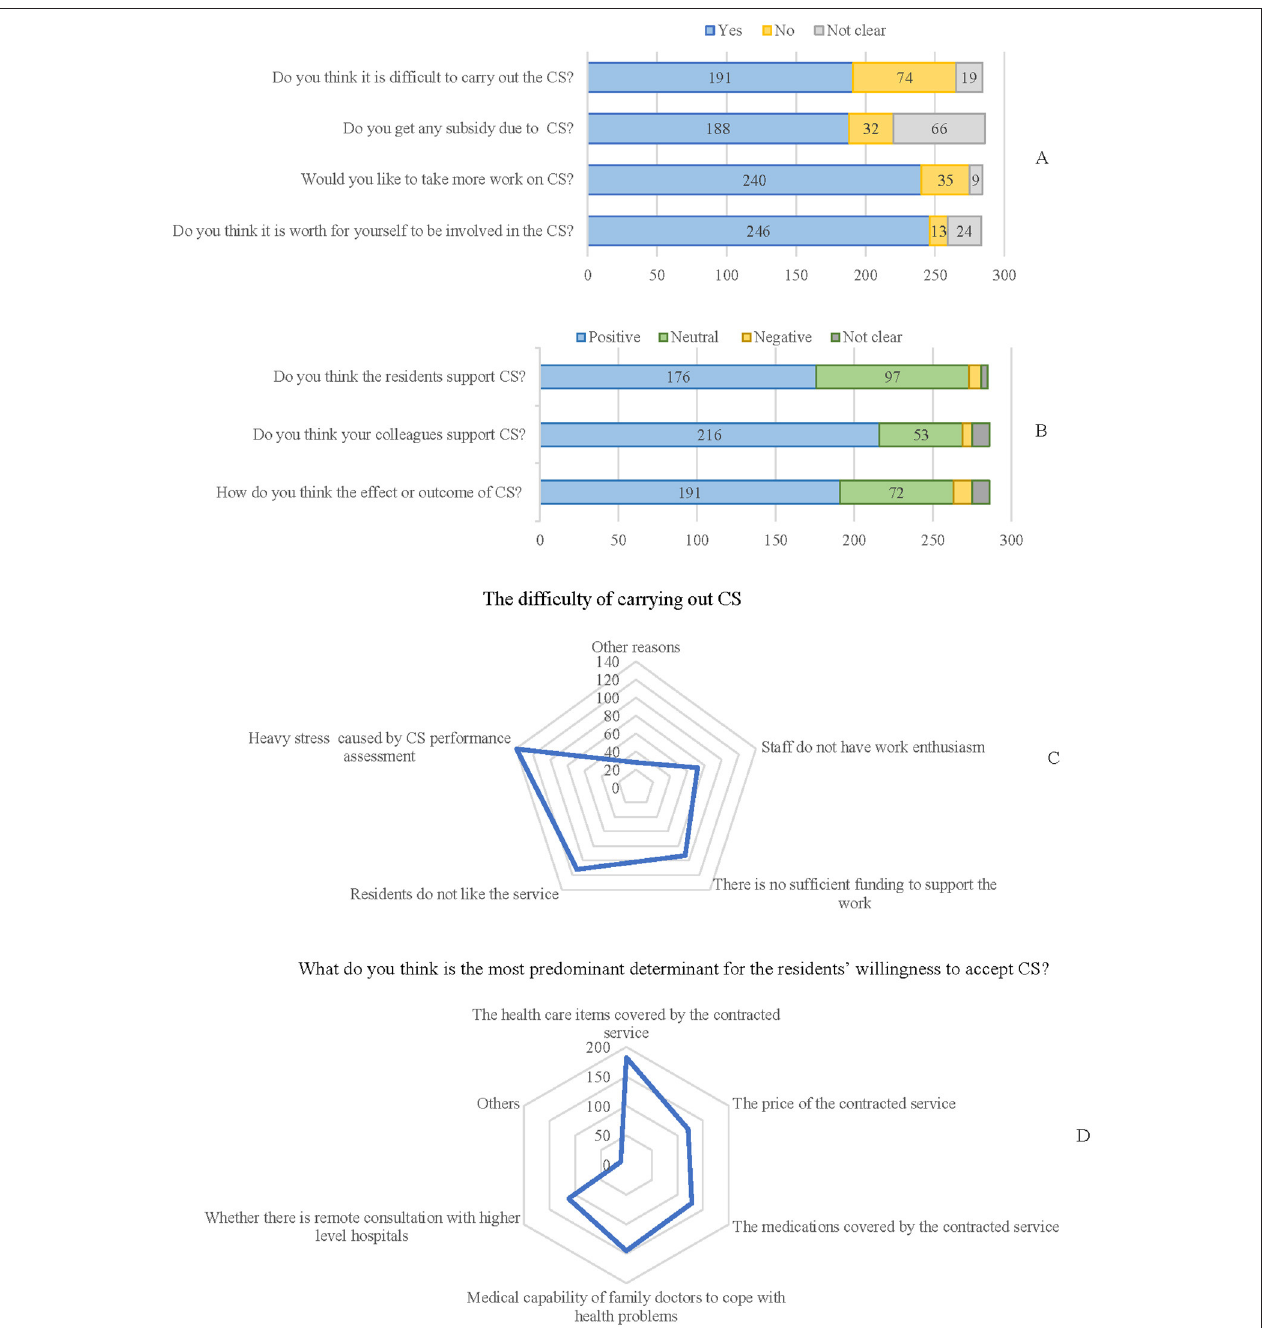
FIGURE 1 | The awareness, perspectives, and attitude of contracted service among the general medical practitioners. (A,B) The awareness, attitude, and perspectives toward contracted service (CS) among participants. (C) The difficulty of carrying out CS. (D) Predominant determinant factors influencing the willingness of CS signing from the perspective of medical